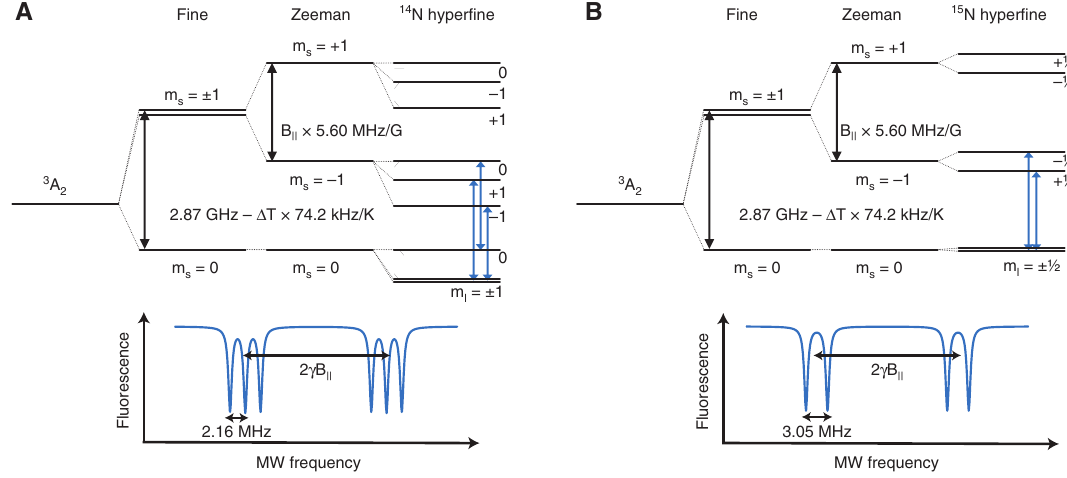
Figure 2: NV ground-state configurations and ODMR Spectra. (A) 14 N hyperfine states and (B) 15 N hyperfine states. Schematic optically detected magentic resonance (ODMR) spectra are shown with Zeeman splitting and hyperfine splitting for 14 N and 15 N. The energy levels for 14 N are further shifted by quadrupolar interactions.